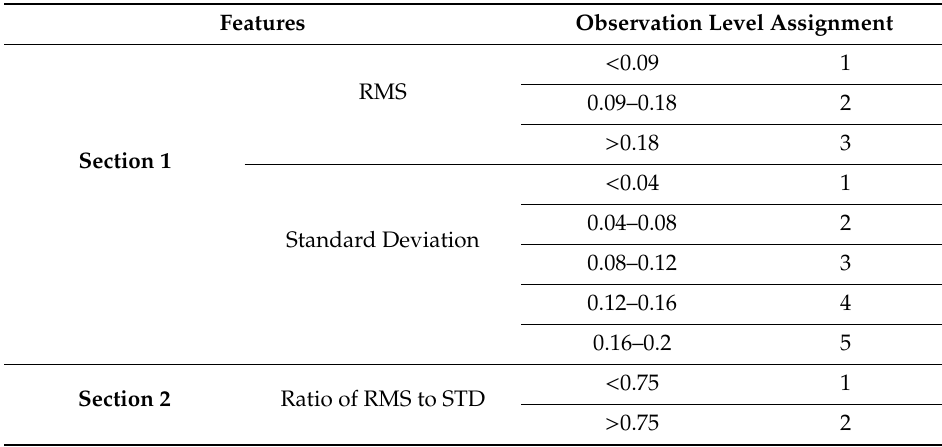
Figure 14. Classification index for each section: ( a ) RMS value; ( b ) STD; ( c ) STD-to-RMS ratio. Table 3. Selected features for hidden Markov model (HMM)-based classifier.